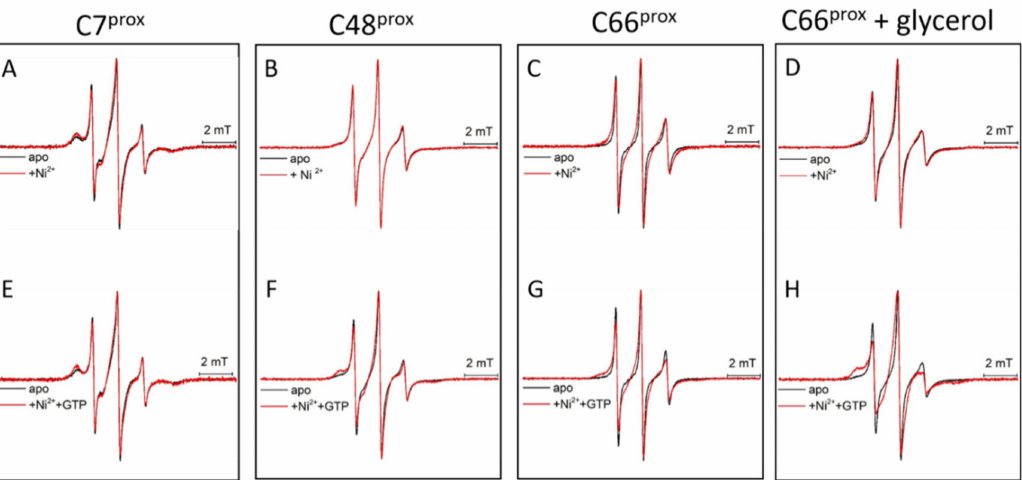
Figure 6. X-band CW EPR spectra of Hp UreG variants at room temperature, in the absence and in the presence of glycerol. In the upper panels ( A – D ), the apo-form spectra are in black, those obtained in presence of 2.5 mM of NiSO 4 are in red. In the lower panels ( E – H ), the apo-form spectra ( black line ) are compared to spectra recorded in presence of either 3 mM GTP and / or 2.5 mM Ni(II) ( red line